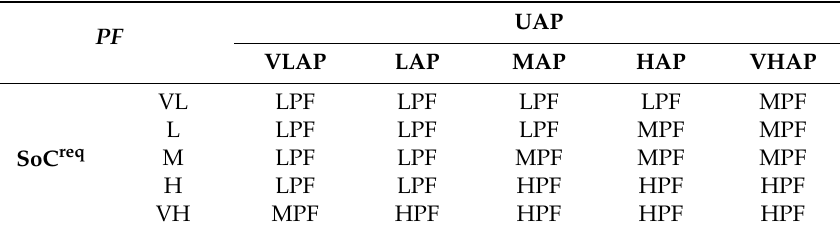
Table 3. Set of fuzzy rules of second stage FIS when RPD is AD. Table 4. Set of fuzzy rules of second stage FIS when RPD is